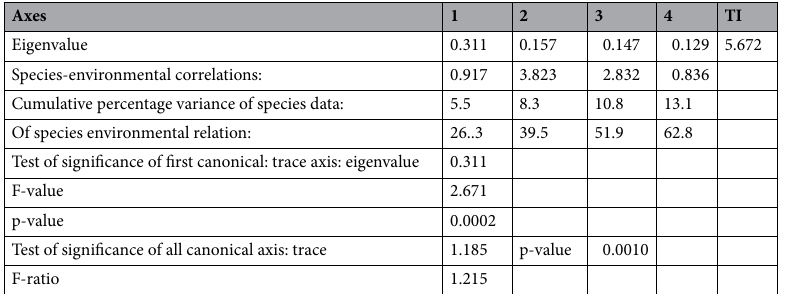
Table 2. Summary of canonical correspondence analysis of vegetation and environmental variables of the studied region.